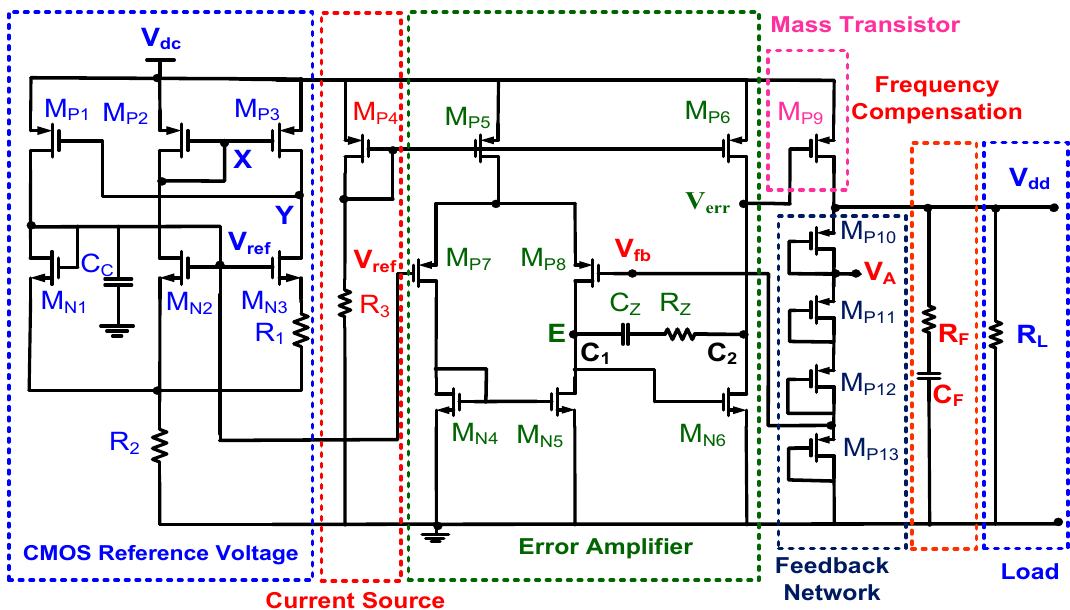
Figure 7. Complete circuit of the low-voltage LDO regulator.